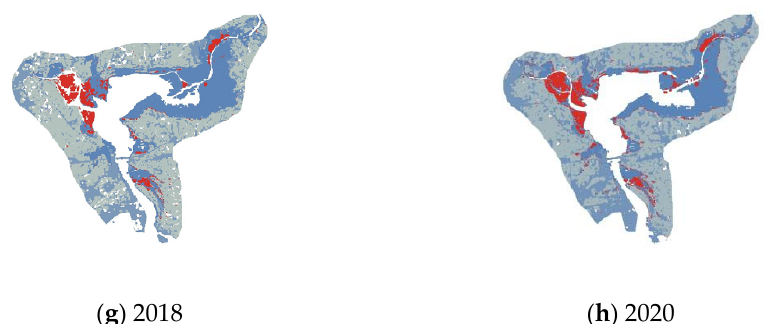
Figure 3. Spatial distribution of carbon stock in the coastal zone in Hainan Province from 1988 to 2020.